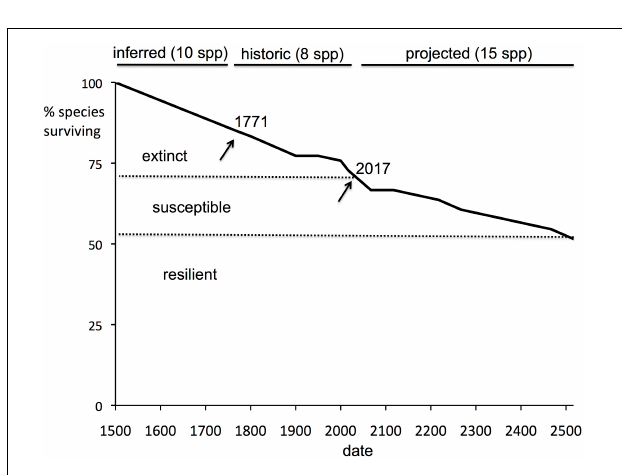
FIGURE 3 | Extinction time course, 1502–2517 as percentage of total flora. A summary of the extinction dynamics of St Helena. “Historic” is actual data; “inferred” is an extrapolation back to 1502 of the historic extinction rate; and “projected” is calculated from a model of current species declines. Despite native ecosystems being reduced to some 3.5% of original levels, less than 30% of the endemic flora is extinct.